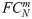
Friendship cycles, stars, and ribbons.The friendship cycle FCNm, the friendship star FSNm and the friendship ribbon FRNm where N is the number of vertices and m is the number of 3-cliques.